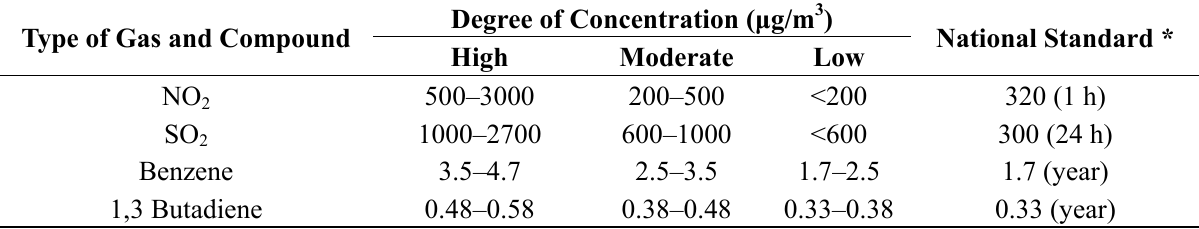
Table 1. Determining degrees of pollutant concentration experienced by local